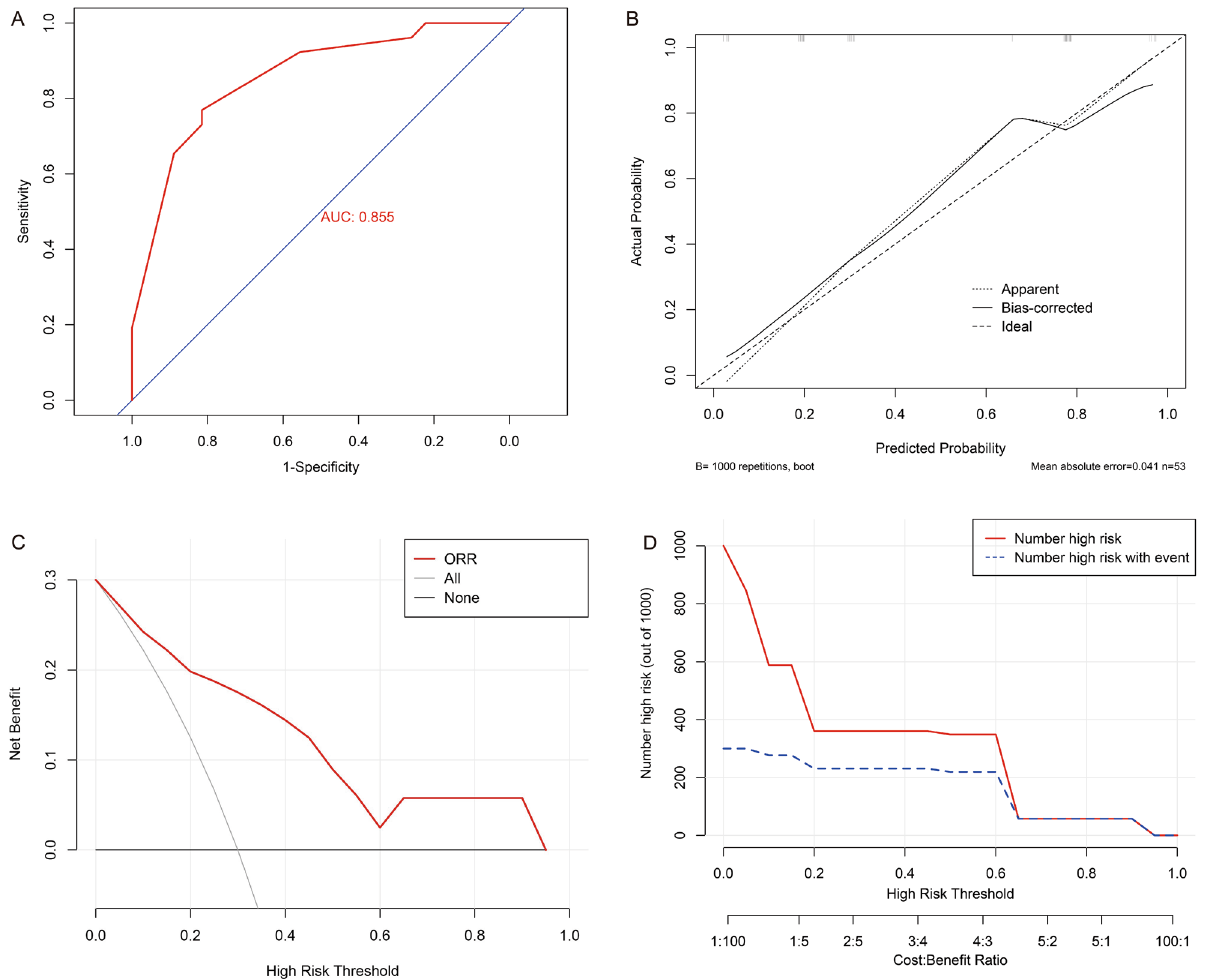
Figure 4. External verification of the nomogram for predicting the ORR after neoadjuvant therapy from validation cohort. ( A ). Receiver operating characteristic curve. ( B ). Bootstrap validation curve. ( C ). Decision curve analysis. ( D ). Clinical impact curve. ORR, objective response